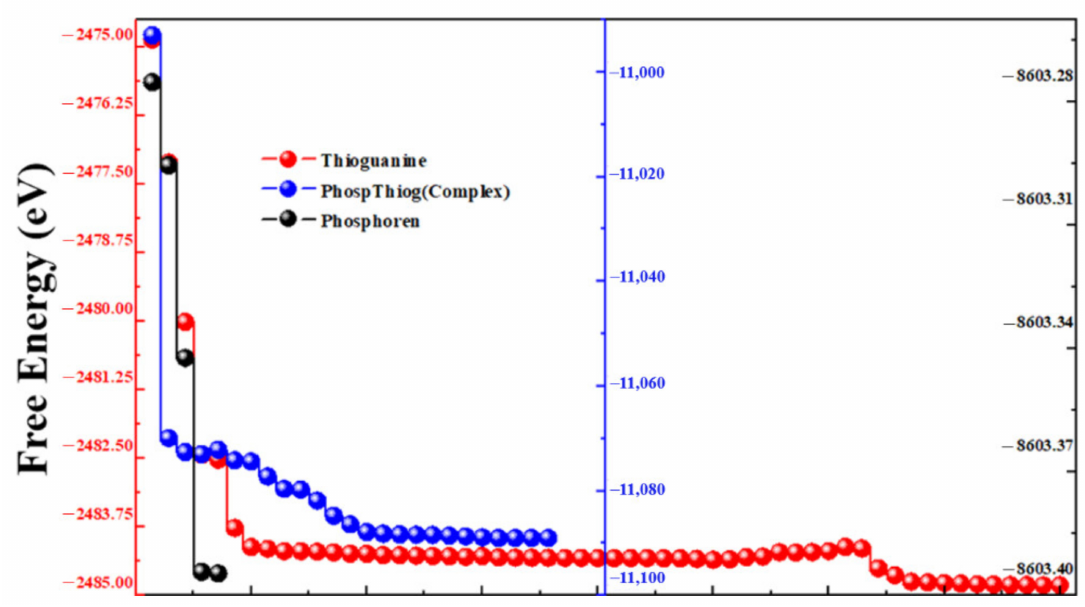
Figure 2. Free energy versus the number of iterations of phosphorene, thioguanine and phosphorene– thioguanine complex.